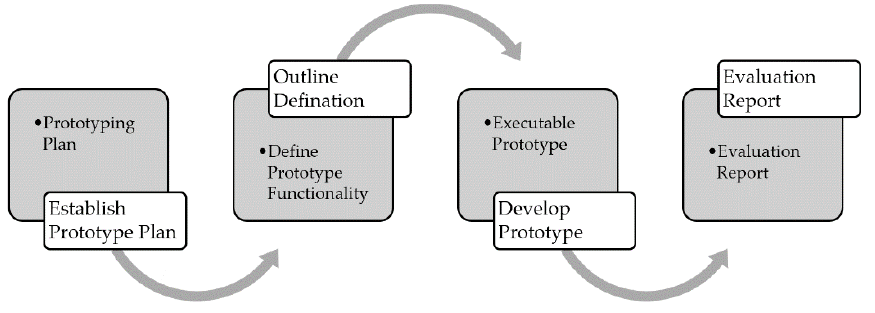
Figure 4. Prototype Development Processes [215].